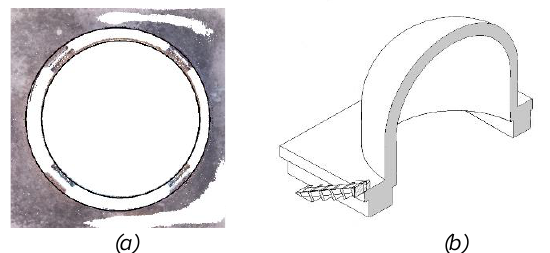
Figure 9. Modelling of the main dome; view in plan (a) and in 3D section (b).